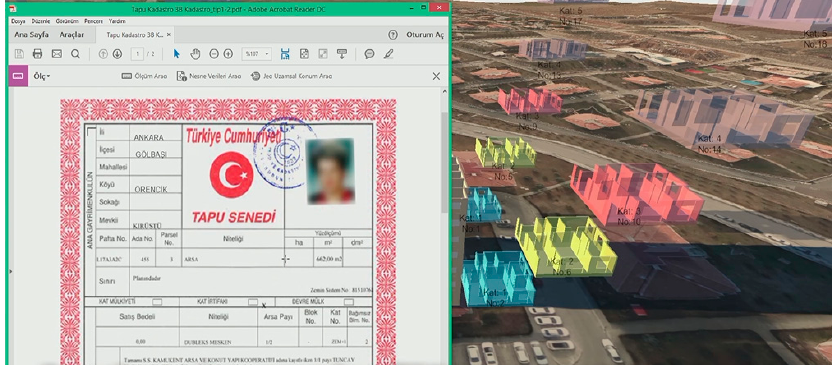
Figure 1. Application interface of the GDLRC 3D Cadaster project, 3D building models (right) and legal information (left) [28].